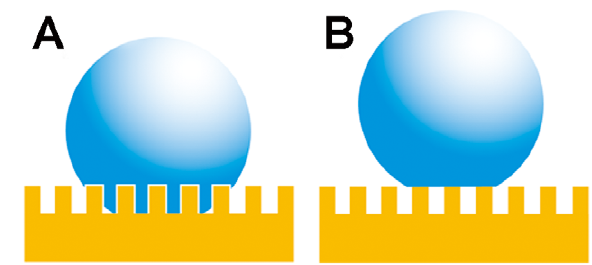
Figure 4. Two wetting states of a liquid on the rough solid surface. (A) Wenzel model; (B) Cassie-Baxter